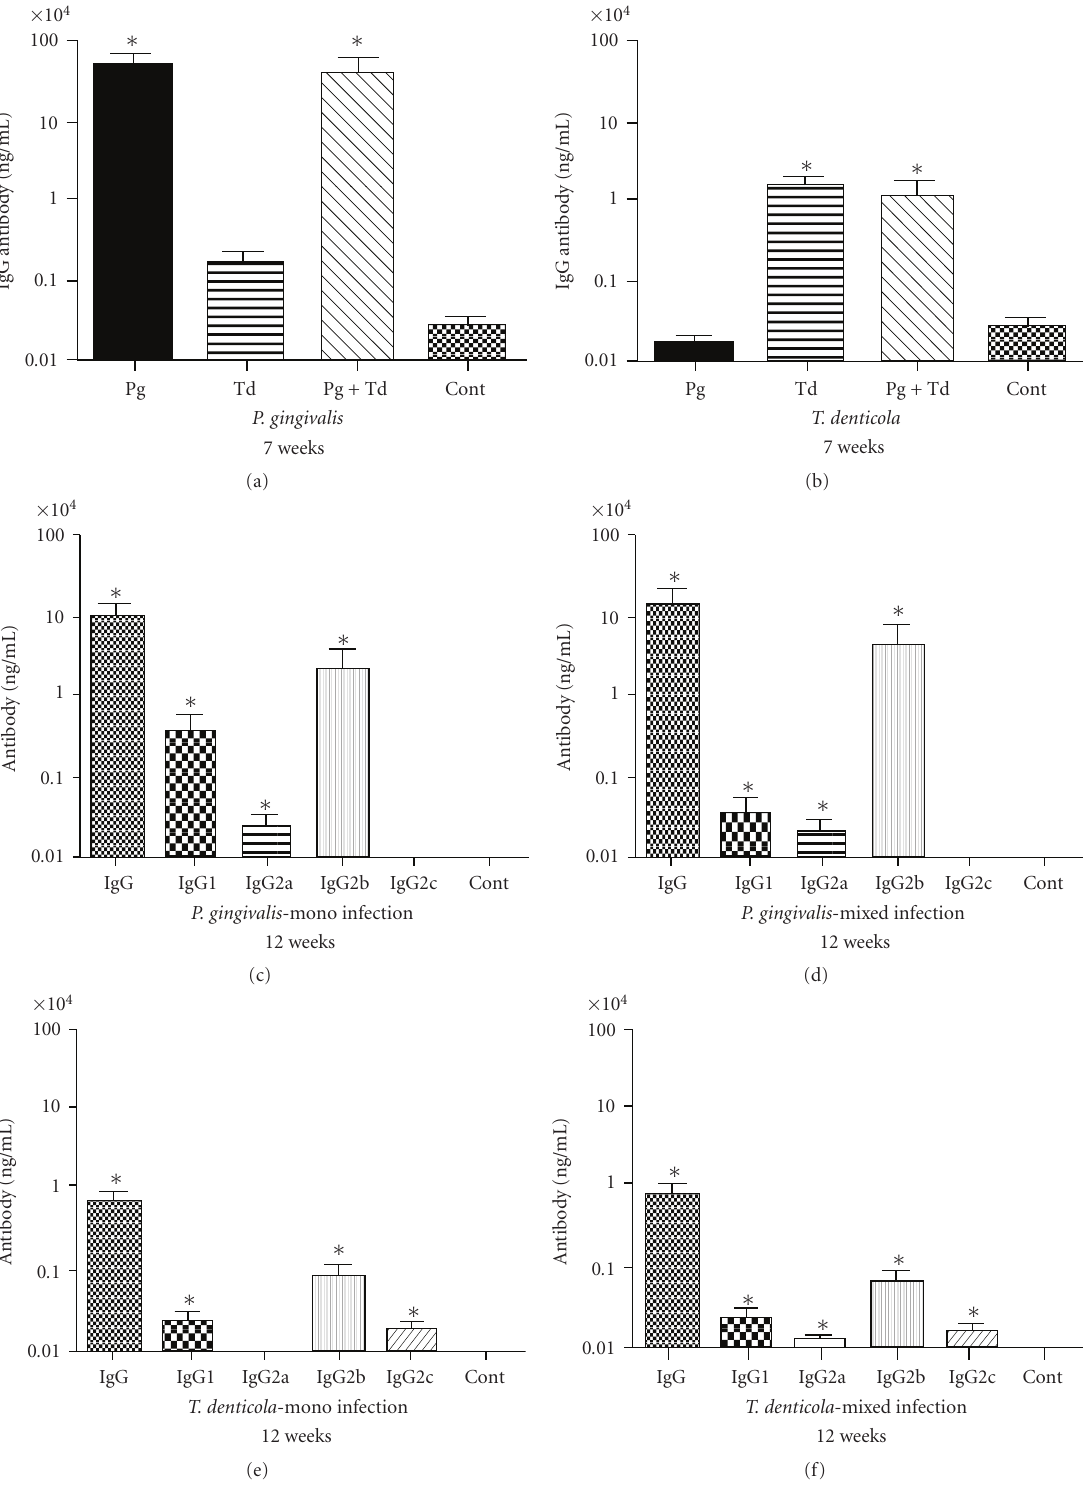
Figure 1: Serum IgG and IgG subclass (IgG1, IgG2a, IgG2b, IgGc) antibody levels. Serum IgG antibody levels in serum from rats [collected at end of a 7 weeks (a and b) and 12 weeks (c–f) infection] following mono infection ( n = 9) or mixed infection ( n = 9). The graphs show the results for IgG and IgG subclass antibody reactive with each of the two species of bacteria. The bars indicate the mean antibody concentrations in serum from rats orally infected with the individual bacteria or with mixed bacteria or from sham-infected control rats. The error bars indicate one standard deviation from the mean. An asterisk indicates that a value is significantly di ff erent ( ∗ P < . 05) than the value for sham-infected control rats or for antibody in serum from rats infected with a di ff erent microorganism. Pg , P. gingivalis ; Td , T. denticola ; Cont; sham-infected